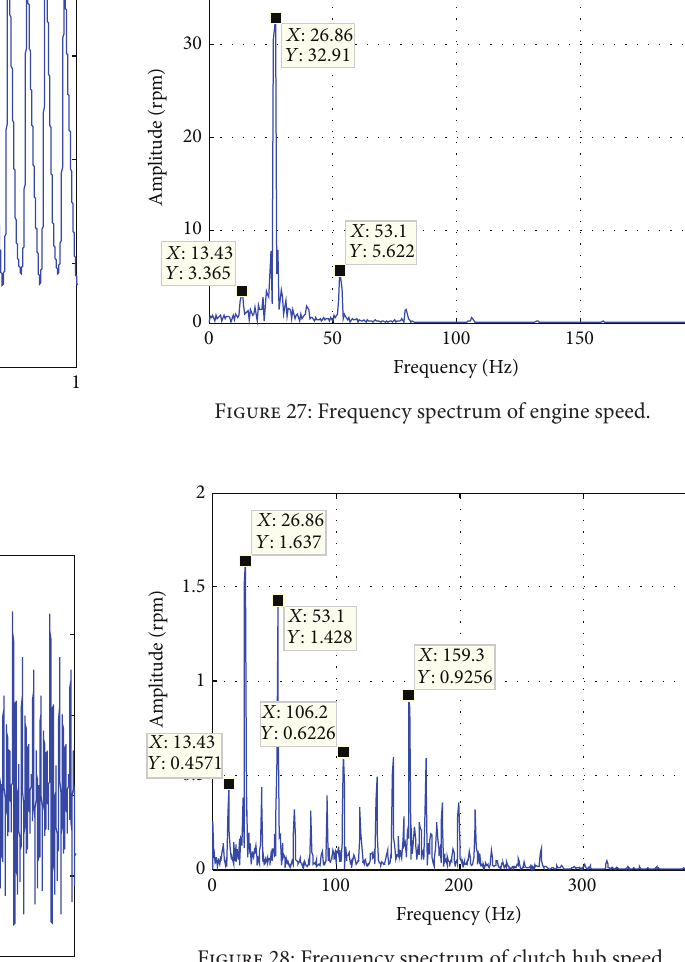
Figure 28: Frequency spectrum of clutch hub